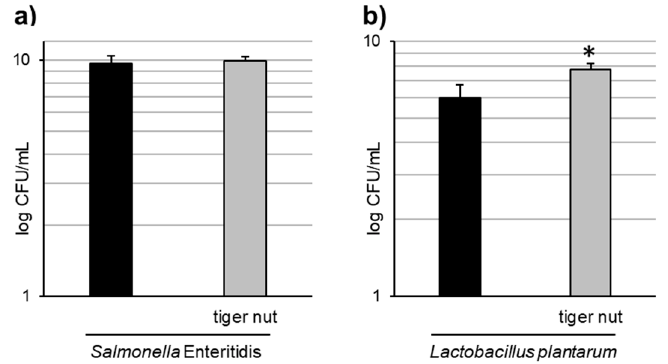
Figure 5. Effect of tiger nut on bacterial growth. ( a ) S . enteritidis growth evaluated in cultures incubated for 3 h in the absence or presence of tiger nut (2.5 mg/mL). Results are expressed as the mean ± SEM of n = 6 experiments. ( b ) L. plantarum growth evaluated in cultures incubated for 24 h in the absence or presence of tiger nut (2.5 mg/mL). Results are expressed as the mean ± SEM of n = 5 experiments. The asterisk denotes statistical differences ( p <